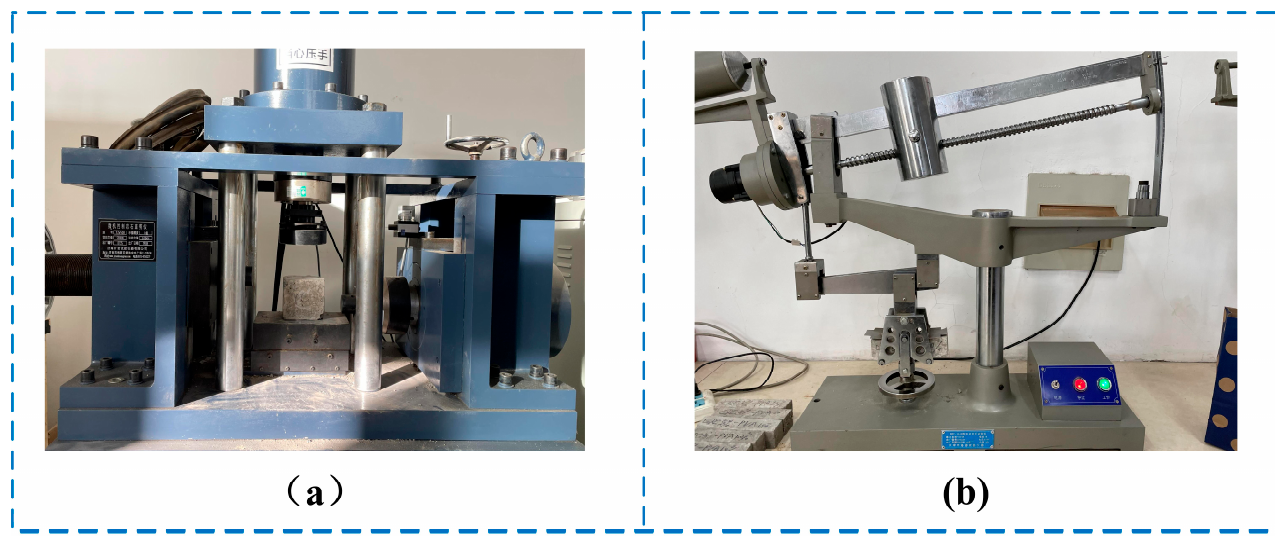
Figure 2. Laboratory equipment: ( a ) Pressure device; ( b ) Breaking device.